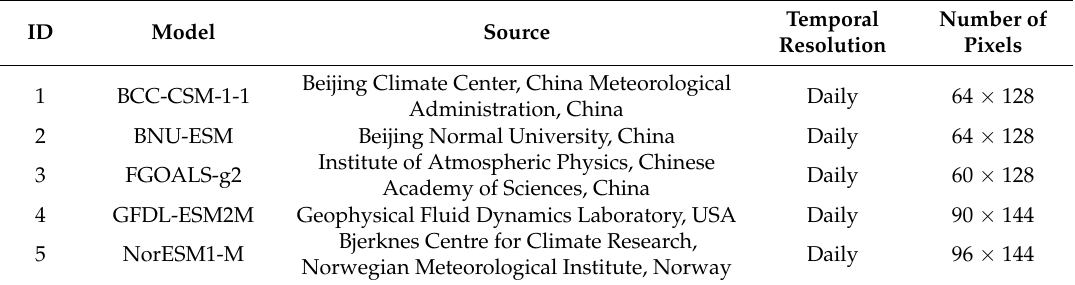
Table 1. List of global climate models in this